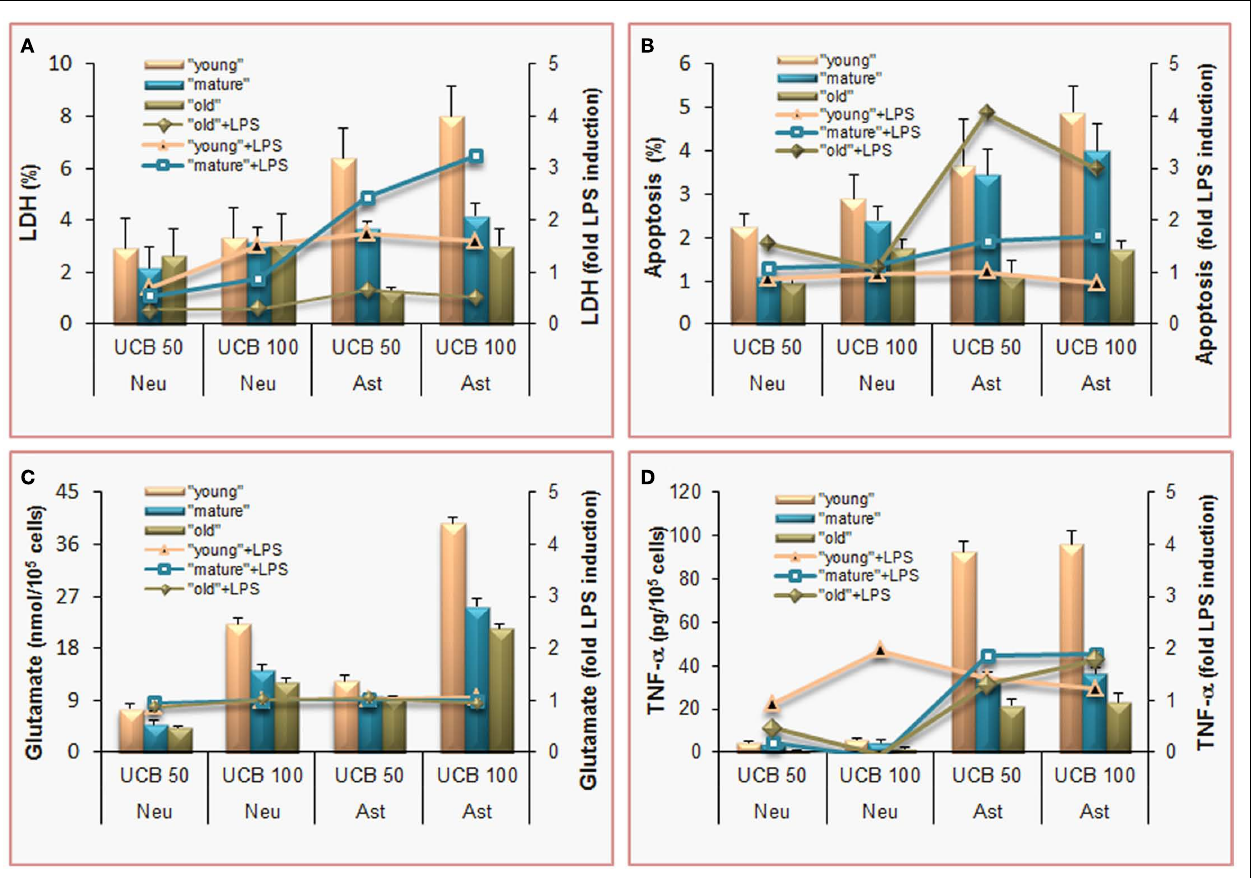
total cell lysis. Astrocytes are the most susceptible cells, and LPS effects are similarly produced in both type of cells, although mature astrocytes are the most vulnerable. (B) Apoptosis was estimated by analysis of nuclear morphology following staining with Hoechst 33258 dye. Immature and mature cells reveal enhanced vulnerability to UCB and old astrocytes greater apoptosis by associated LPS. (C) Release of glutamate to the incubation medium proportionally increases with UCB concentration and it is not modified by LPS co-incubation. (D) The pro-inflammatory cytokine tumor necrosis factor (TNF)- α is released to the culture medium mainly by astrocytes and always increase by LPS addition. Mean values ± SEM are differences from the respective control, for all the parameters except for the fold increase by LPS, which data are means. Data derived from Fernandes et al. (2004) and Falcão et al. (2005, 2006,